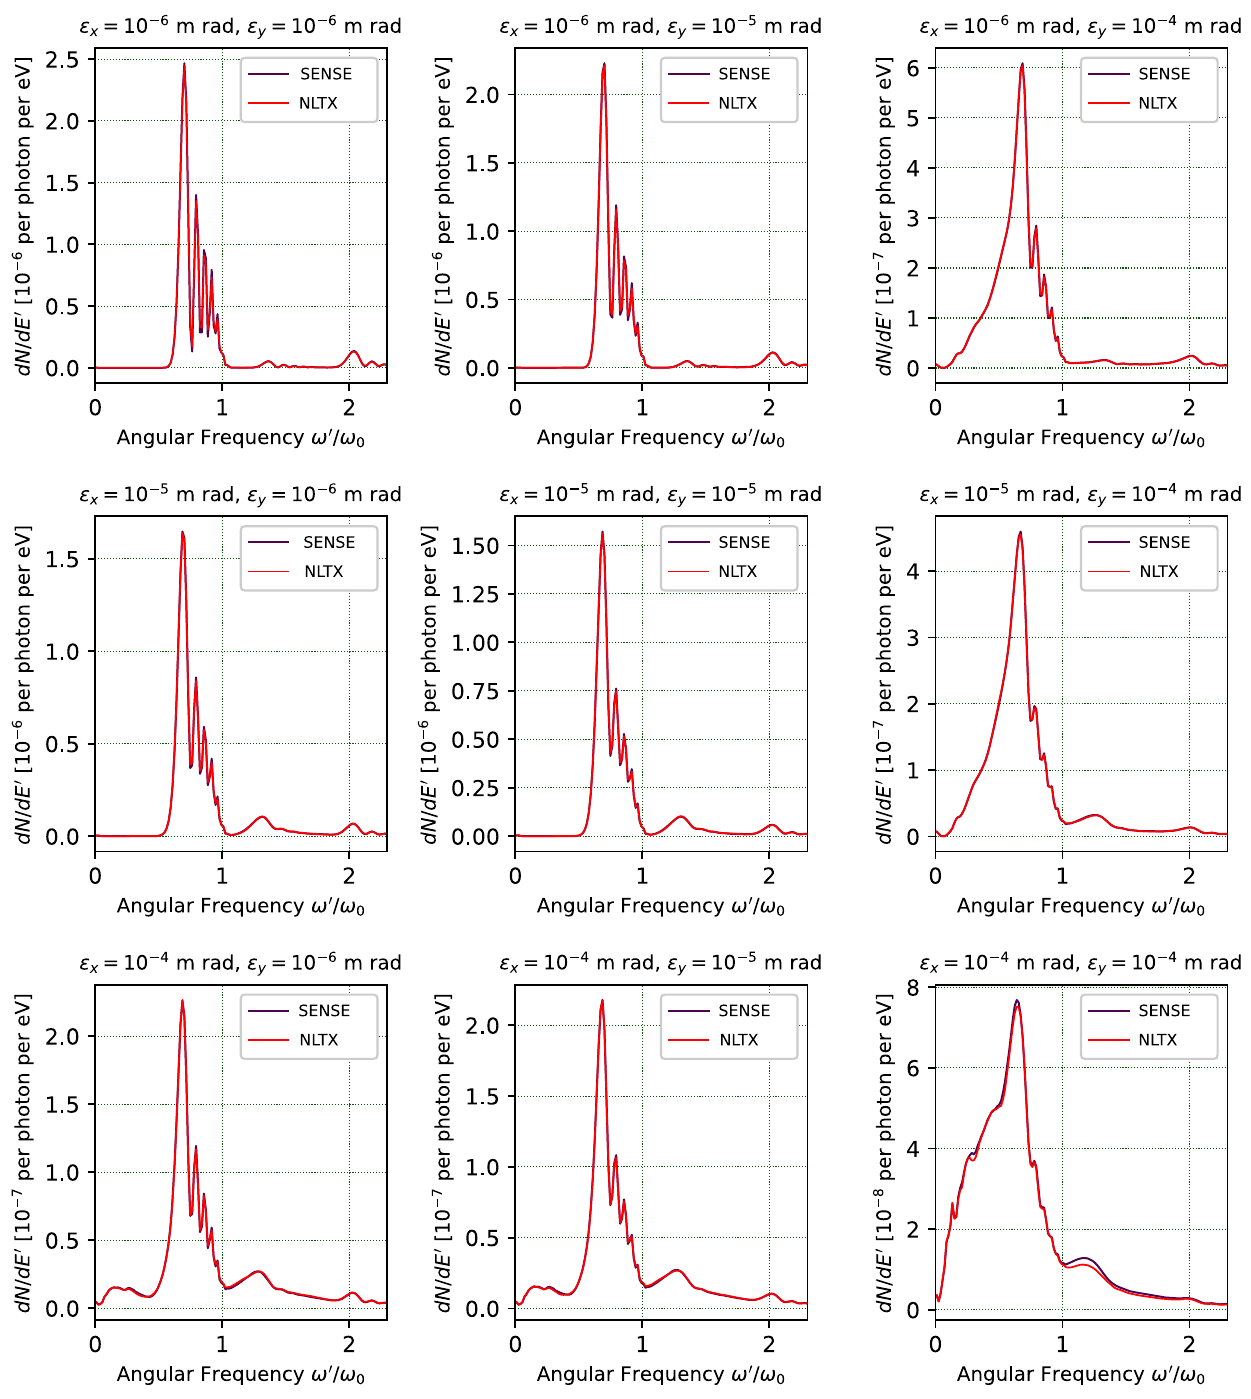
FIG. 4. Simulated spectra from SENSE and NLTX for field strength a 0 ¼ 1 . 0 and a range of normalized horizontal emittance ϵ x and normalized vertical emittance ϵ y values. The following parameters were used in the simulations: E e ¼ 23 MeV; Δ E e =E e ¼ 0 . 175% , σ ¼ 41 μ m; σ ¼ 81 μ m; λ ¼ 800 nm; σ ¼ 13 . 59 μ m; σ ¼ 13 . 59 μ m; σ ¼ 5 . 57 . The scattered frequency is scaled by the x y x;l y;l normalizing frequency ω 0 ¼ 2 π c= λ